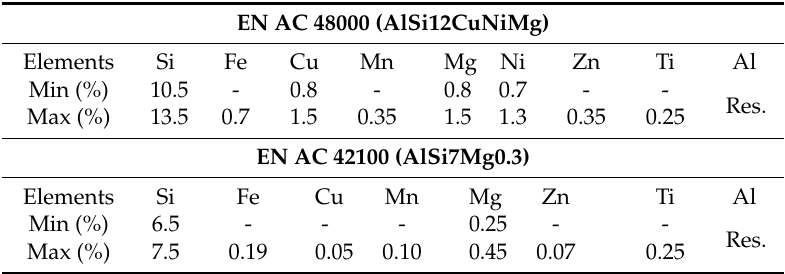
Table 1. Alloy composition